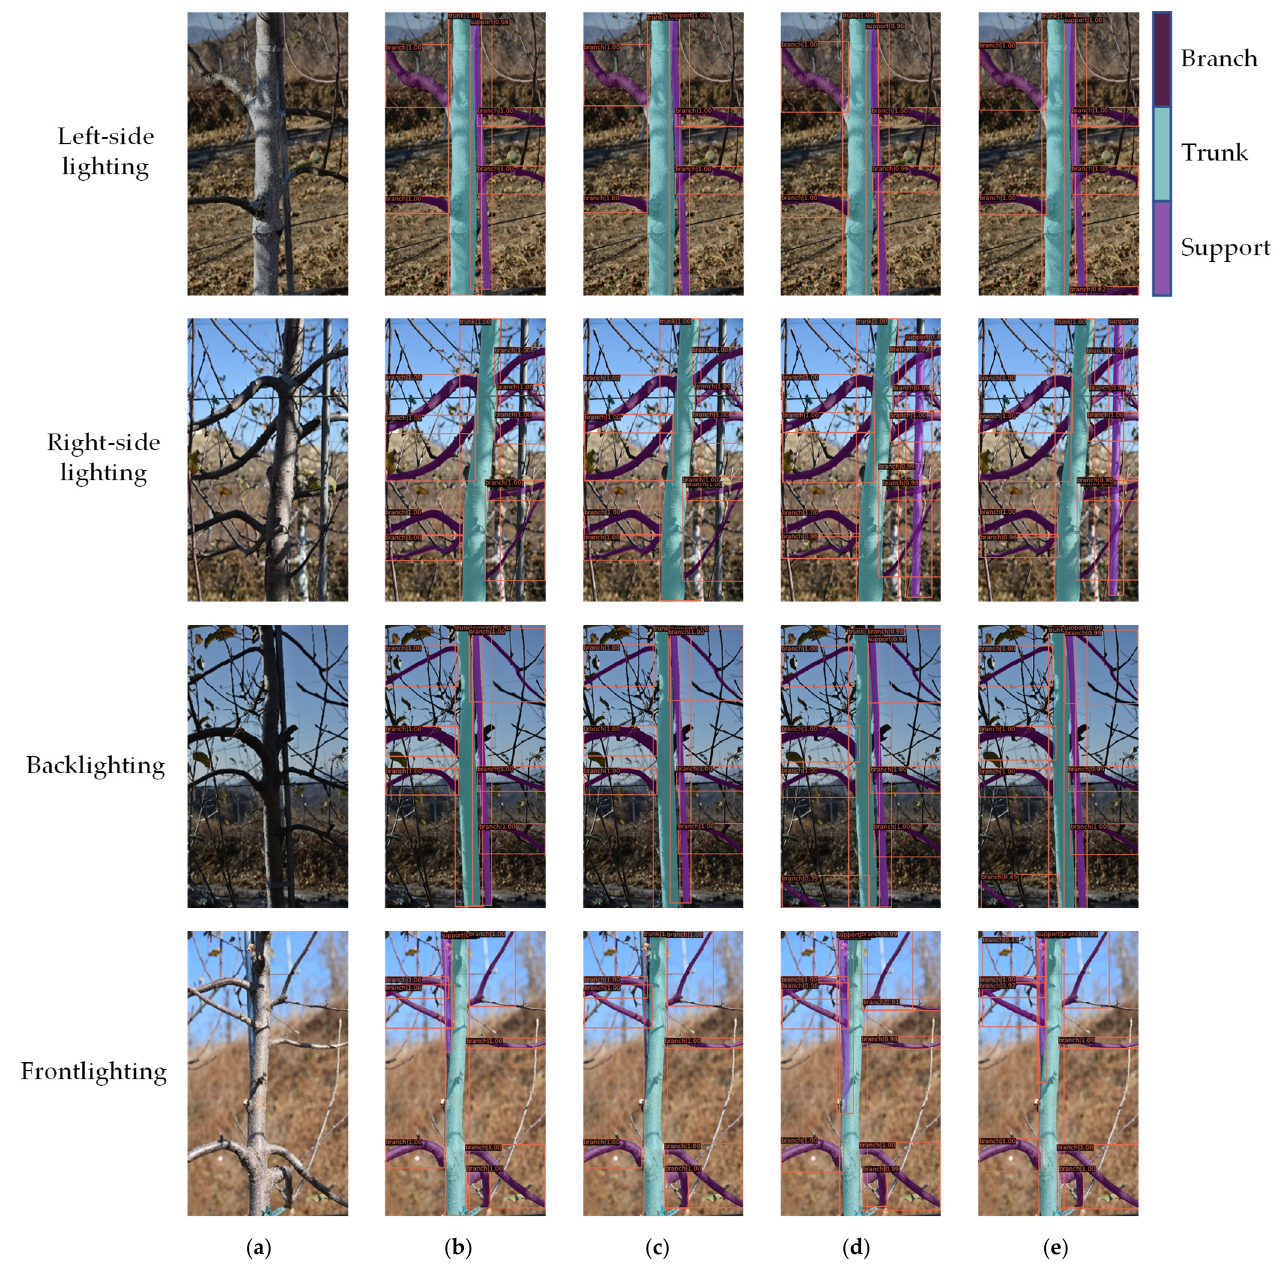
Figure 11. Prediction graphs of four algorithms for detection and segmentation in different scenarios: ( a ) input image; ( b ) identification result of Mask R-CNN R50; ( c ) identification result of Cascade Mask R-CNN R50; ( d ) identification result of Mask R-CNN SW-T; ( e ) identification result of Cascade Mask R-CNN SW-T.